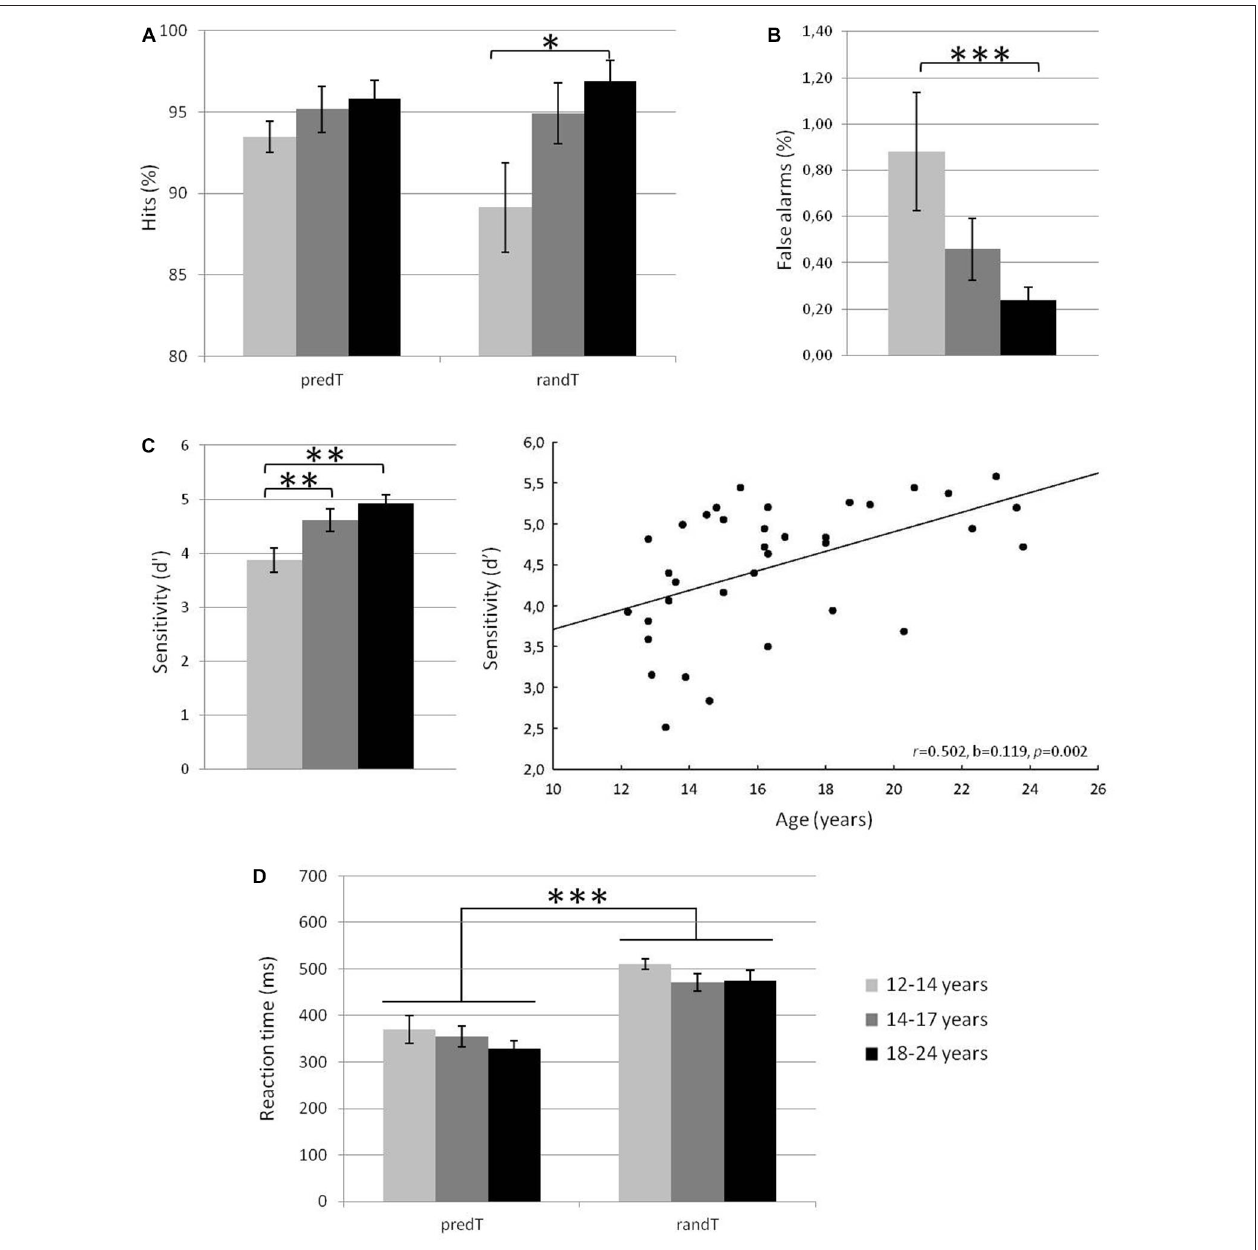
FIGURE 2 | Mean % of hits for predicted and random targets in the three age groups (A), % of false alarms (FAs) in the three age groups (B), sensitivity d (cid:48) in the three age groups and plotted against age in years (C) and reaction times (RTs) in ms for predicted and random targets in the three age groups (D). Error bars: standard errors of mean. Significant differences are indicated by asterisks: ∗ p ≤ 0.05, ∗∗ p ≤ 0.01, ∗∗∗ p ≤ 0.001.